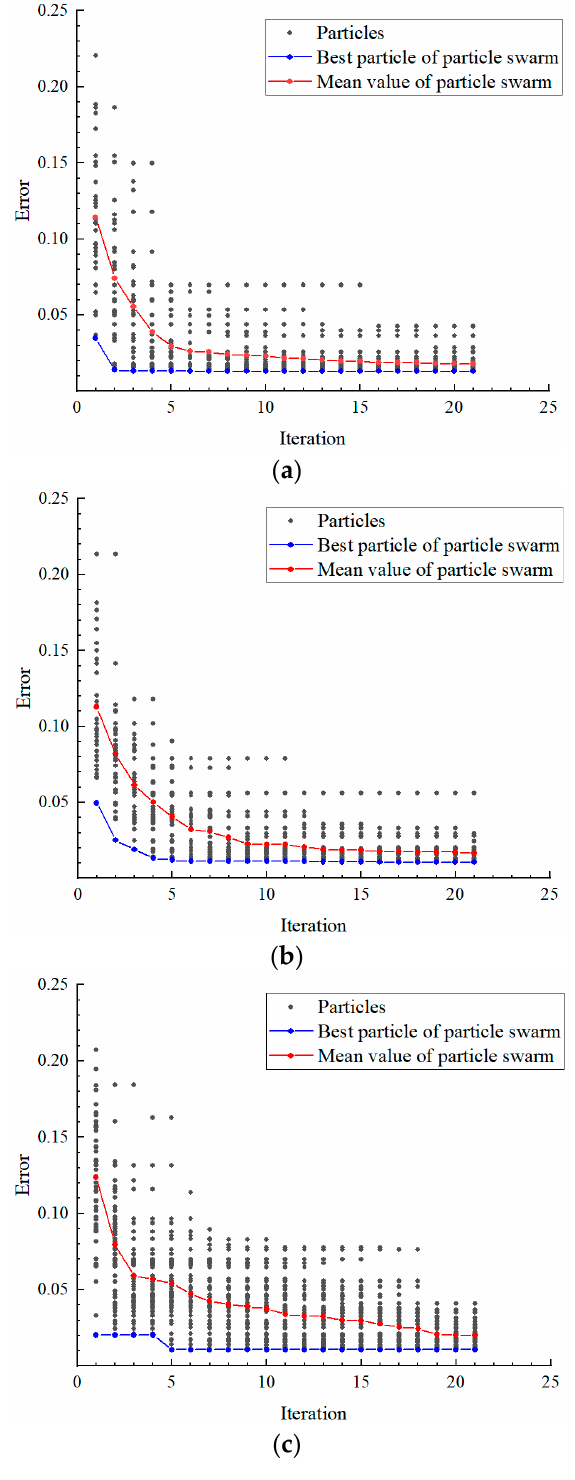
Figure 13. Convergence plots of the PSO simulations for the second approach using different numbers of particles. ( a ) 20 particles, ( b ) 30 particles, and ( c ) 50 particles.